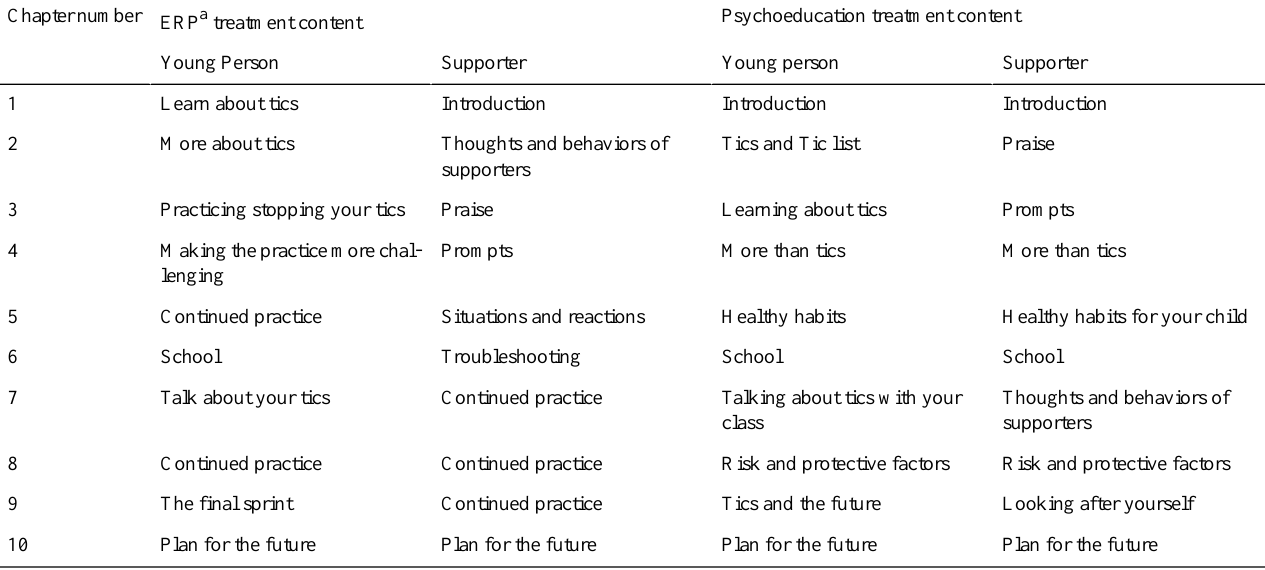
Table 1. Chapters of the ORBIT